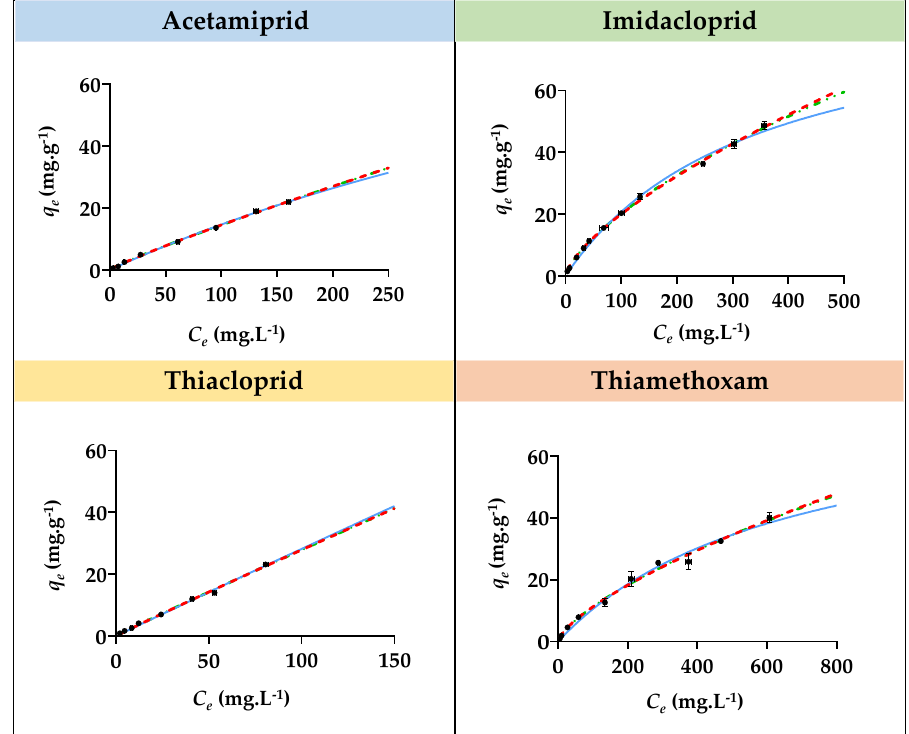
Figure 6. Adsorption isotherms curves for imidacloprid, acetamiprid, thiacloprid, and thiamethoxam insecticides with [Si][N 3888 ]Cl. The black dots correspond to experimental data, the continuous blue line corresponds to the fitting of the experimental data with the Langmuir model, the red dashed line corresponds to the fitting with the Freundlich model, and the green dashed and pointed line corresponds to the fitting with the SIPS model.